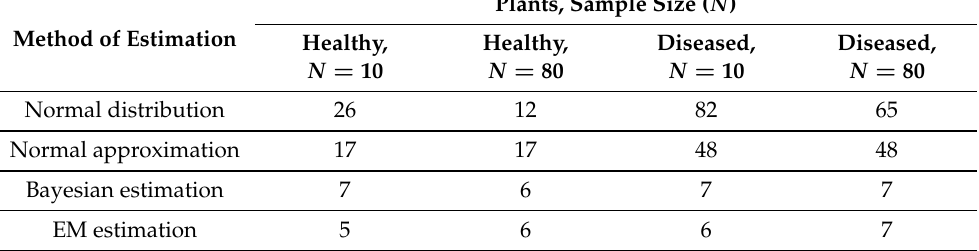
Table 11. Mean value of the relative error (%) for the five times of the experiment per method of estimation and per number of observations for Healthy and Diseased plants of the fungal pathogen data